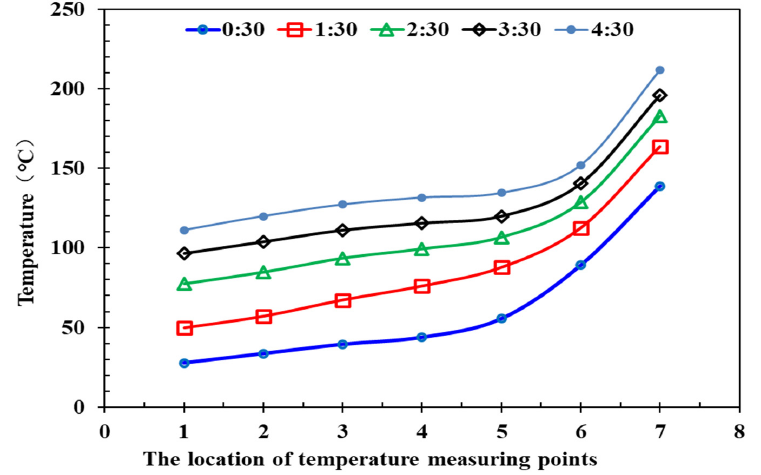
Figure 3. The heat transfer characteristics of model while injecting water. Figure 3. T he heat transfer characteristics of model while injecting water. Figure 3. T he heat transfer characteristics of model while injecting water.